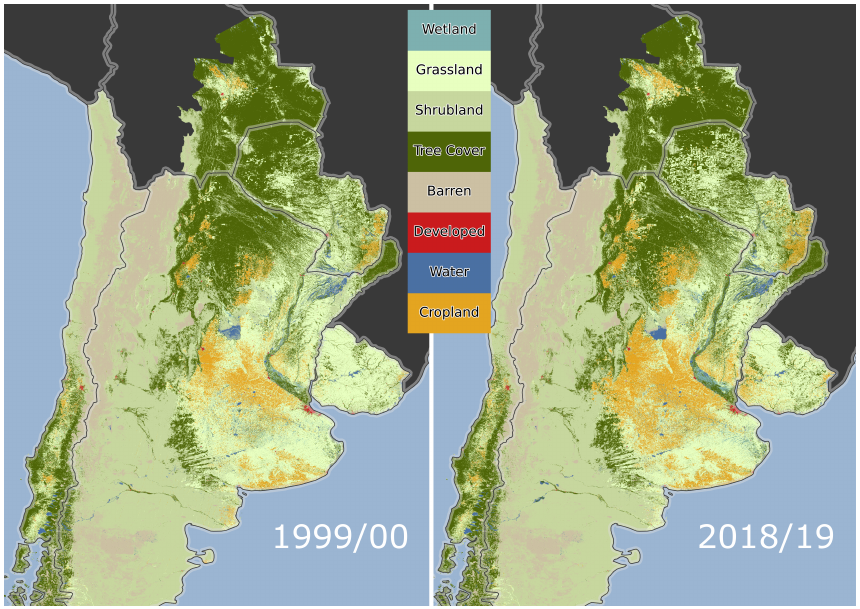
Figure 6. Overview of classification results for the beginning ( left panel) and end ( right panel) of the study period at 30 m spatial